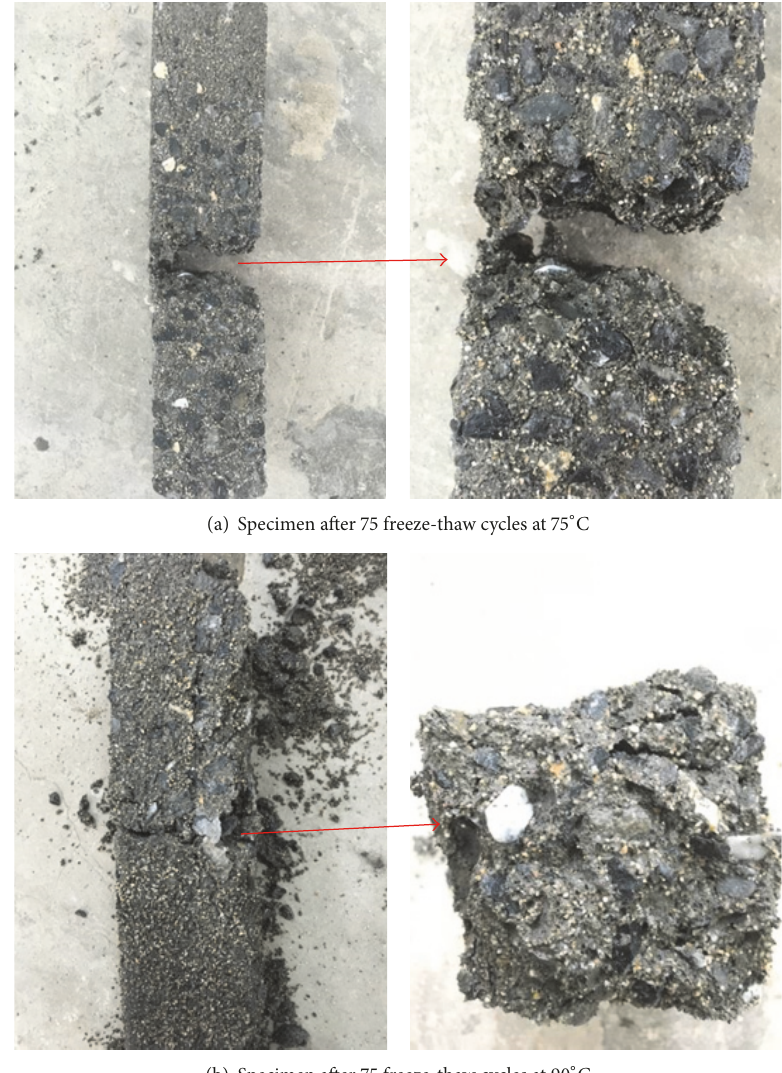
Figure 8: Specimen after 75 freeze-thaw